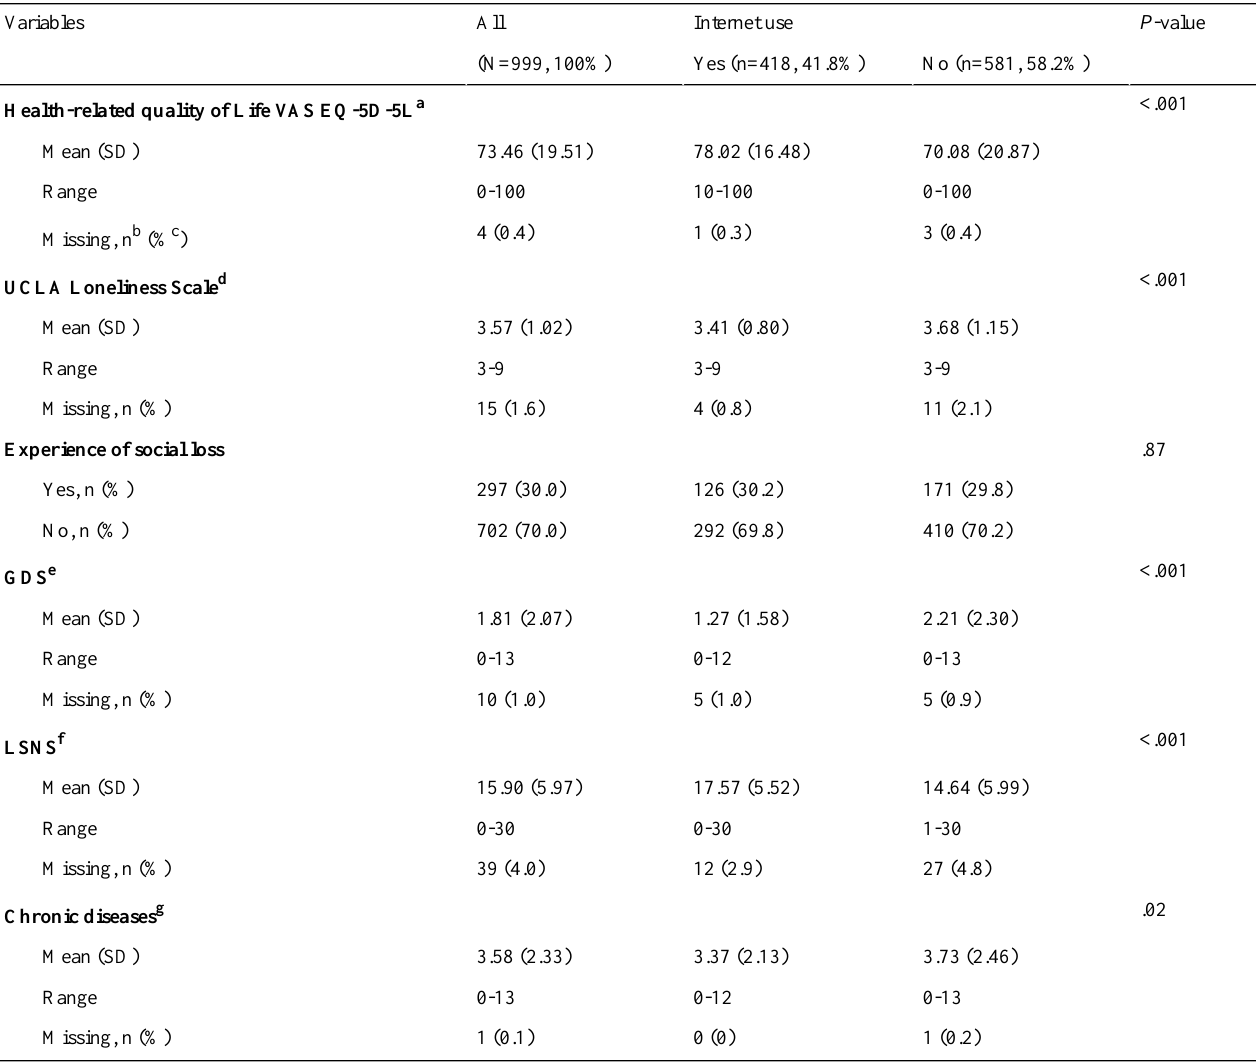
Table 2. Social and health outcomes of the sample (N=999).